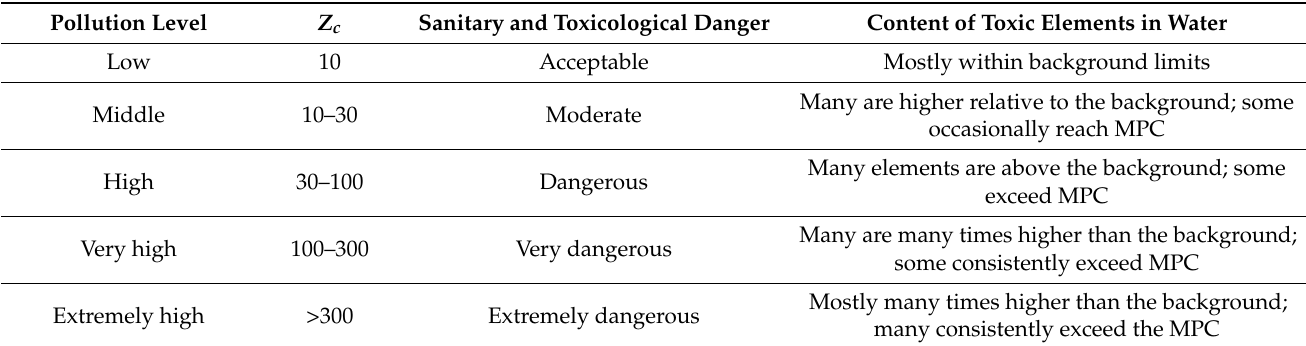
Table 4. Indicative scale by pollution index Z c for water pollution assessment [69] with the help of heavy metal concentrations in bottom sediment.